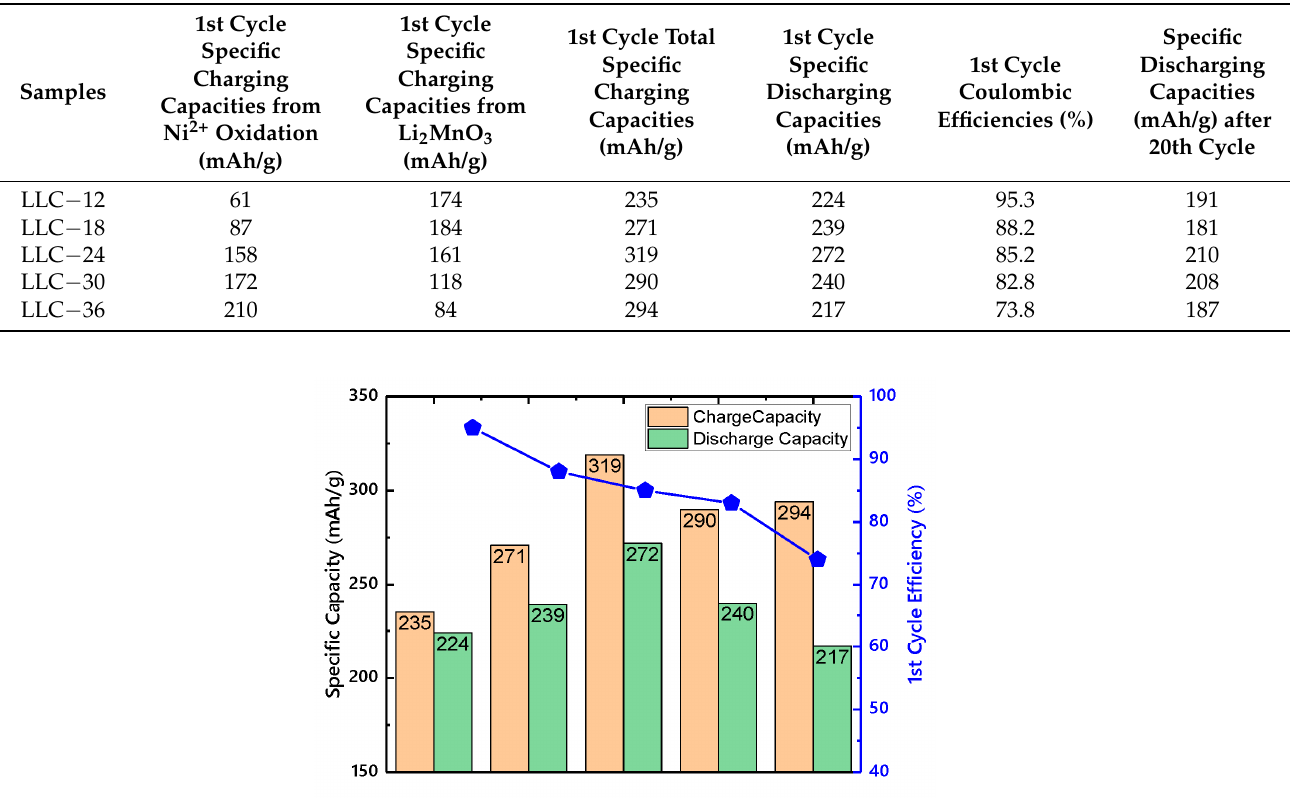
between the transition metal layer and the Li ion layer, which avoids the formation of the spinel-like structure and mitigates the voltage decay within certain Mn/Ni ratios.